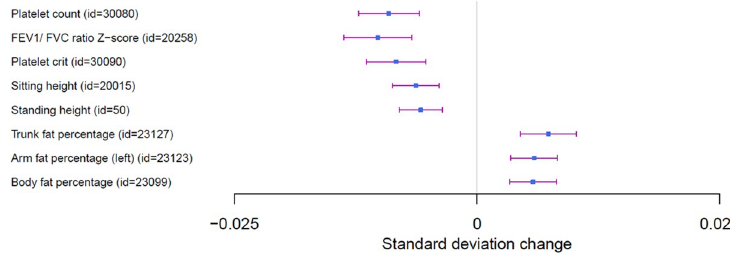
Fig 2. Forest plot of PheWAS analyses of hospitalised COVID-19